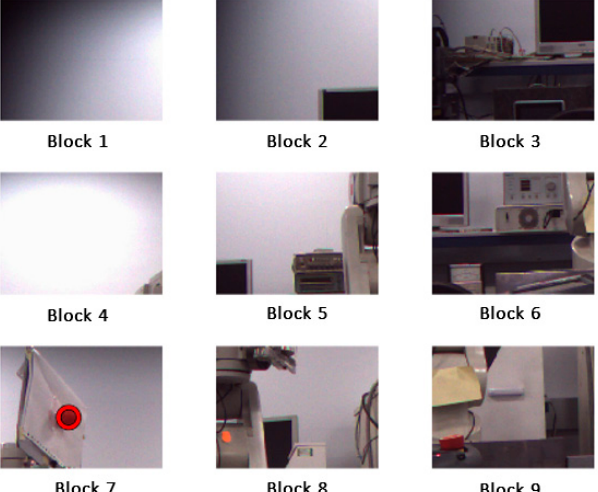
Figure 6. Block processing of the captured image.